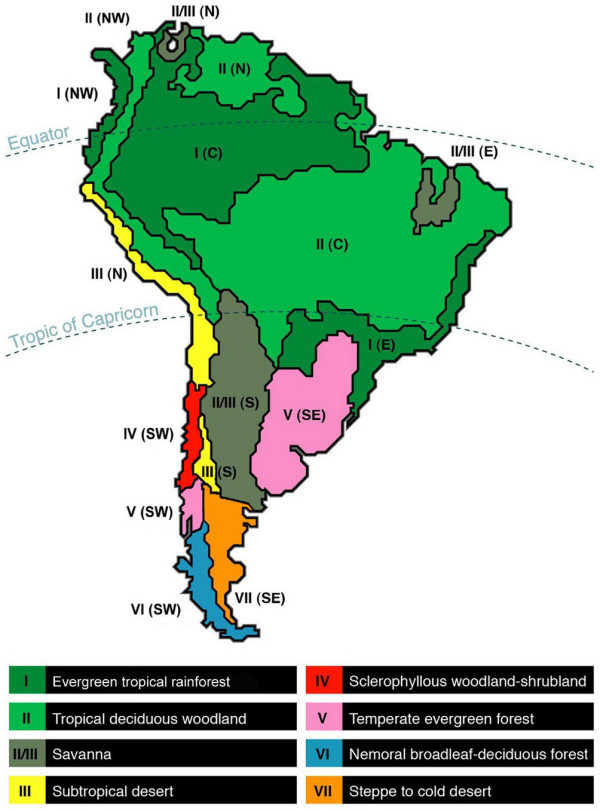
Map of South American climatic dominions. Modified after [67]. Abbreviations as in Table 8.